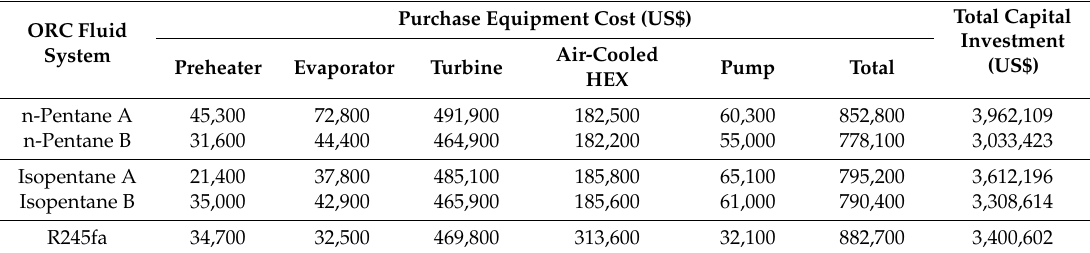
Table 6. Total Capital Investment for Optimum